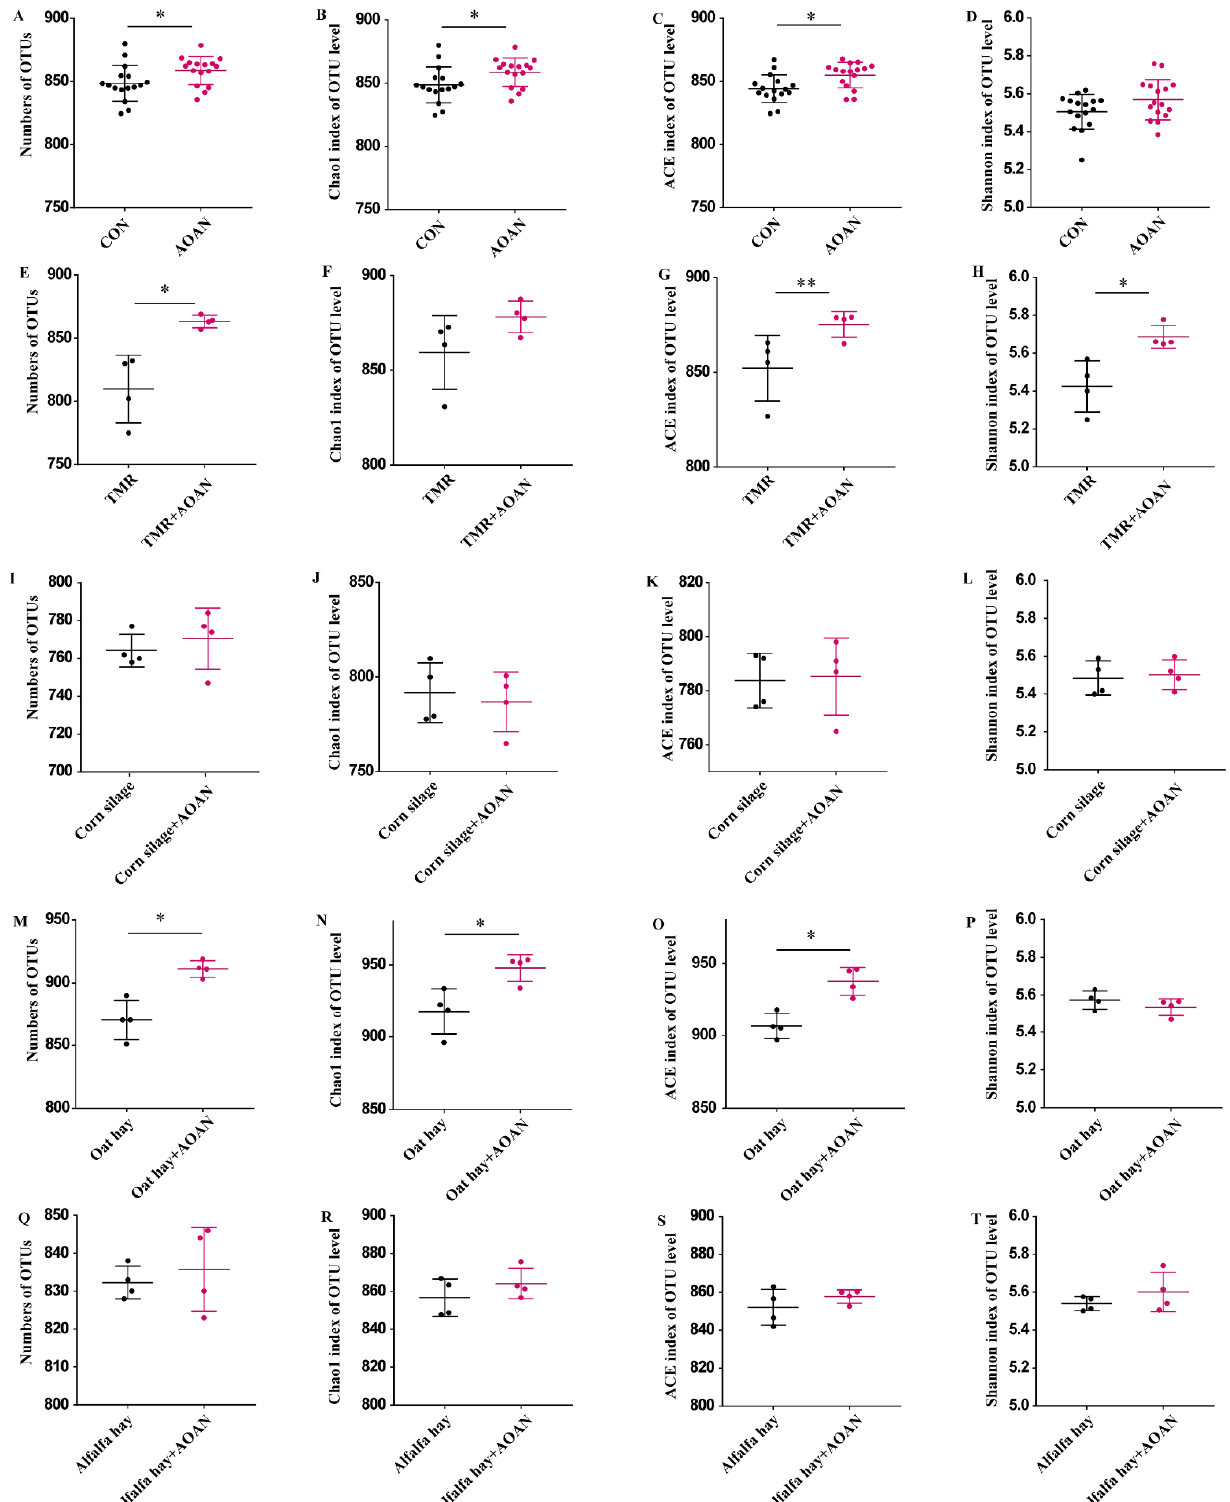
Figure 5. Effects of Aspergillus oryzae and Aspergillus niger co-cultivation fermentation extract on α diversity based on OTU level of TMR ( E – H ), corn silage ( I – L ), oat hay ( M – P ), alfalfa hay ( Q – T ), and all ( A – D ). AOAN indicates fermentation with Aspergillus oryzae and Aspergillus niger co-cultivation fermentation extract. CON group indicates all feeds without AOAN supplementation. AOAN group indicates all feeds with AOAN supplementation. *, p < 0.05; **, 0.05 < p < 0.1. TMR, total mixed ration.